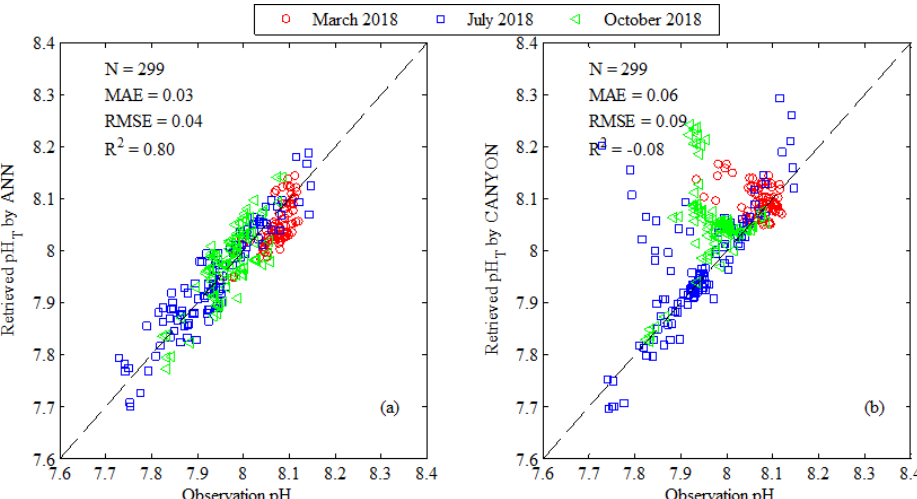
Figure 8. Comparison of retrieved pH T with corresponding observations for exploratory dataset. (a) pH T retrieved by the ANN model vs. observations; (b) pH T retrieved by CANYON (Sauzède et al., 2017) vs. observations. The red circles represent March 2018, the blue squares represent July 2018 and the green triangles represent October 2018. The 1 : 1 line is shown in the plot as a visual reference. Three statistics approaches used are the mean absolute error (MAE), the root mean square error (RMSE) and the coefficient of determination ( R 2 ). N represents the number of data points.